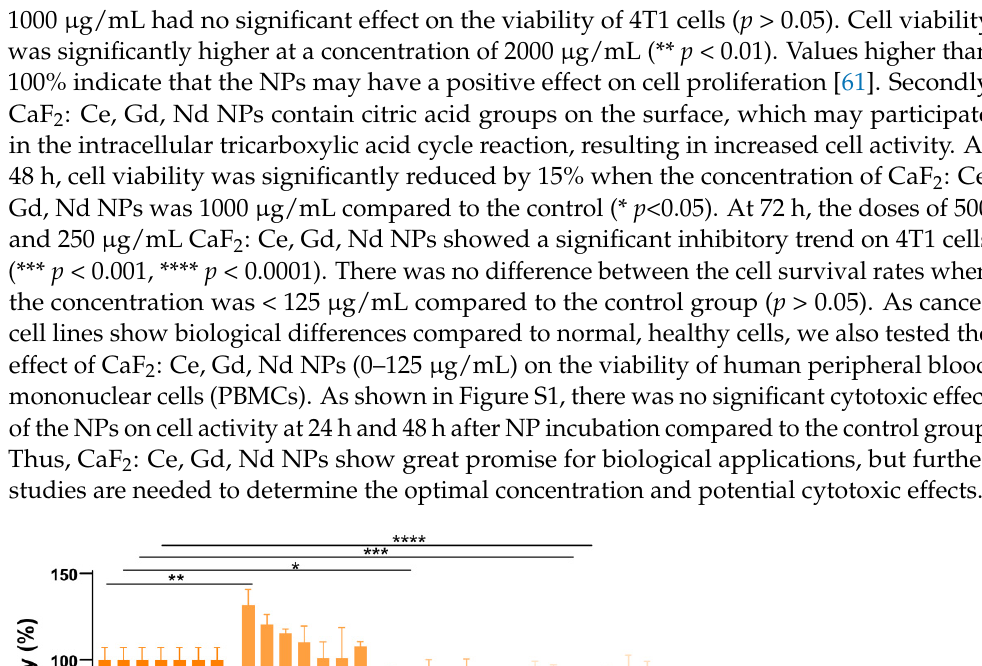
12 of 20 Figure 3. Stability of CaF 2 : Ce, Gd, Nd NPs. ( a ) Size of CaF 2 : Ce, Gd, Nd NPs in 50% FCS; ( b ) Zeta potential of CaF 2 : Ce, Gd, Nd NPs in 50% FCS; ( c ) hemolysis of CaF 2 : Ce, Gd, Nd NPs after incuba- tion with red blood cells at multiple concentrations (0–1 mg/mL) for 4 h, with PBS and deionized water serving as negative and positive controls, respectively; ( d ) hemolysis photo after centrifuga- tion. All data presented the mean values ± SD from three independent trials. By comparing experi- mental groups to control group, one-way ANOVA was used to determine statistical significance (**** p < 0.0001).